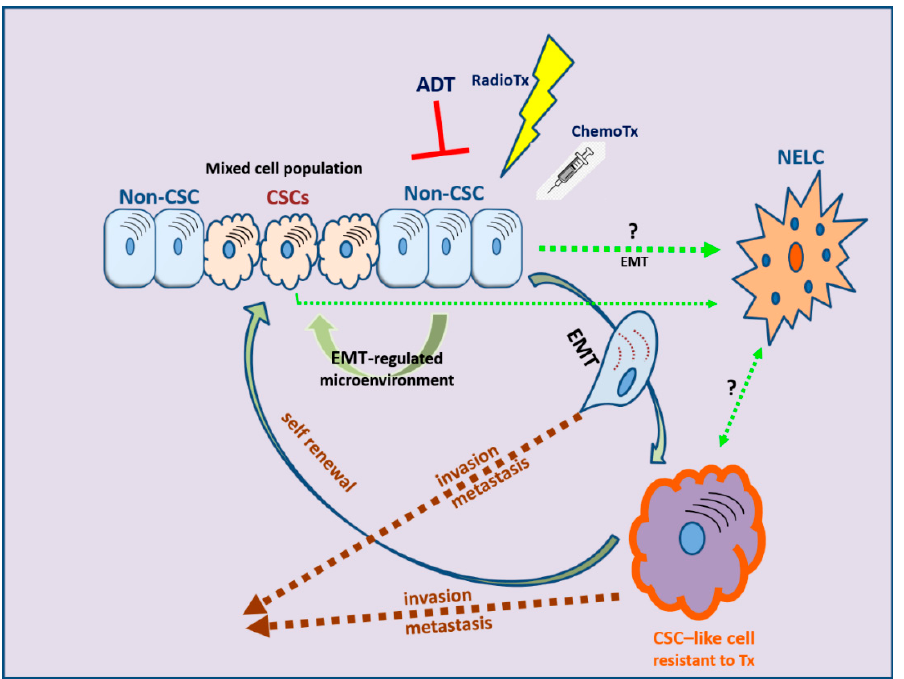
Figure 3. The development of therapy resistance: the complex interlinks among therapeutic manipulations, EMT, and cancer stem cell (CSC) development. NELC: neuro-endocrine-like cell; ADT: androgen deprivation therapy; RadioTx: radiotherapy; ChemoTx: chemotherapy.